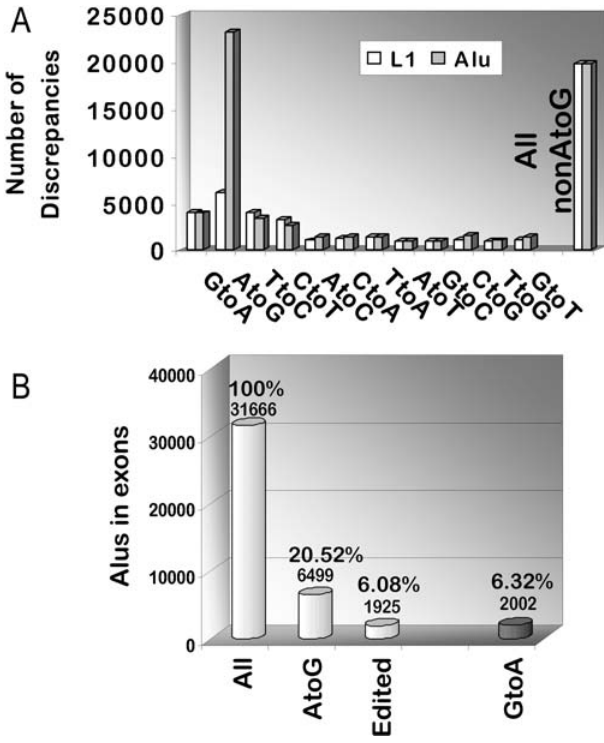
Figure 6. Mismatch Bias in Exonic Repetitive-Element Sequences (A) Plot of the nature and number of mismatches within Alu and L1 sequences present in human cDNAs. For reasons of comparison the L1 mismatch numbers have been multiplied by 2.9 so that the non- AtoG mismatch count for Alu and L1 is identical. Transition mismatches AtoG, GtoA, CtoT, and TtoC are displayed together for comparison. (B) Plotted are the total number of Alu sequences found in human cDNAs (first column) and the number of elements harboring AtoG and GtoA mismatches (second and last column). The third column indicates the high confidence set of edited elements ( a =